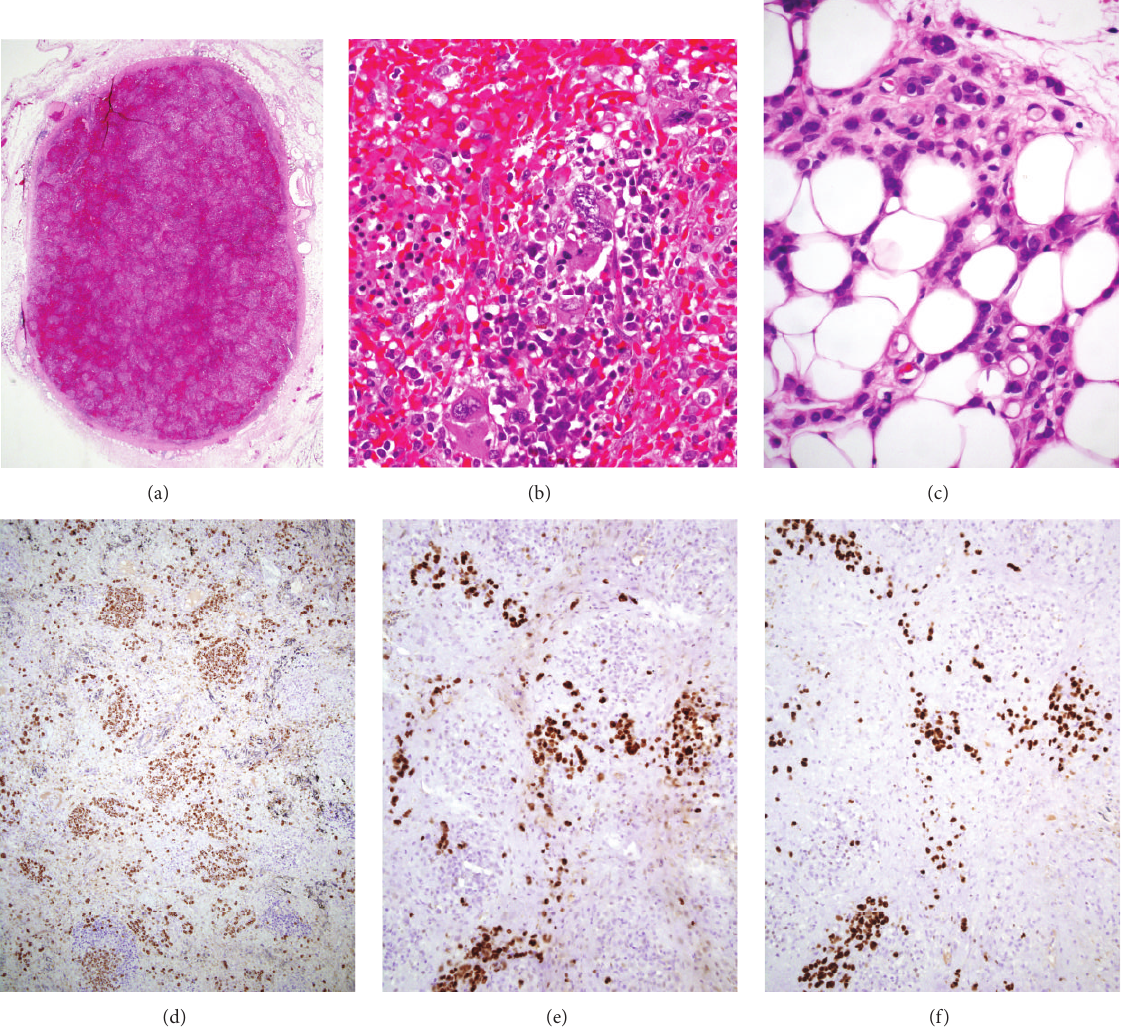
Figure 2: (a) Low power microscopic view of the accessory spleen showing marked congestion and a nodular pattern (hematoxylin and eosin stained section, magnification × 20). (b) High power view shows extramedullary hematopoiesis including atypical megakaryocytes (hematoxylin and eosin stained section, magnification × 400). (c) Small cells with occasional cytoplasmic vacuoles resembling lobular carcinoma cells infiltrate the fatty tissue (hematoxylin and eosin stained section, magnification × 400). (d) Cytokeratin stain highlights numerous cells that represent metastatic carcinoma (magnification × 100). (e) Estrogen receptors and (f) GATA3 strongly stain the